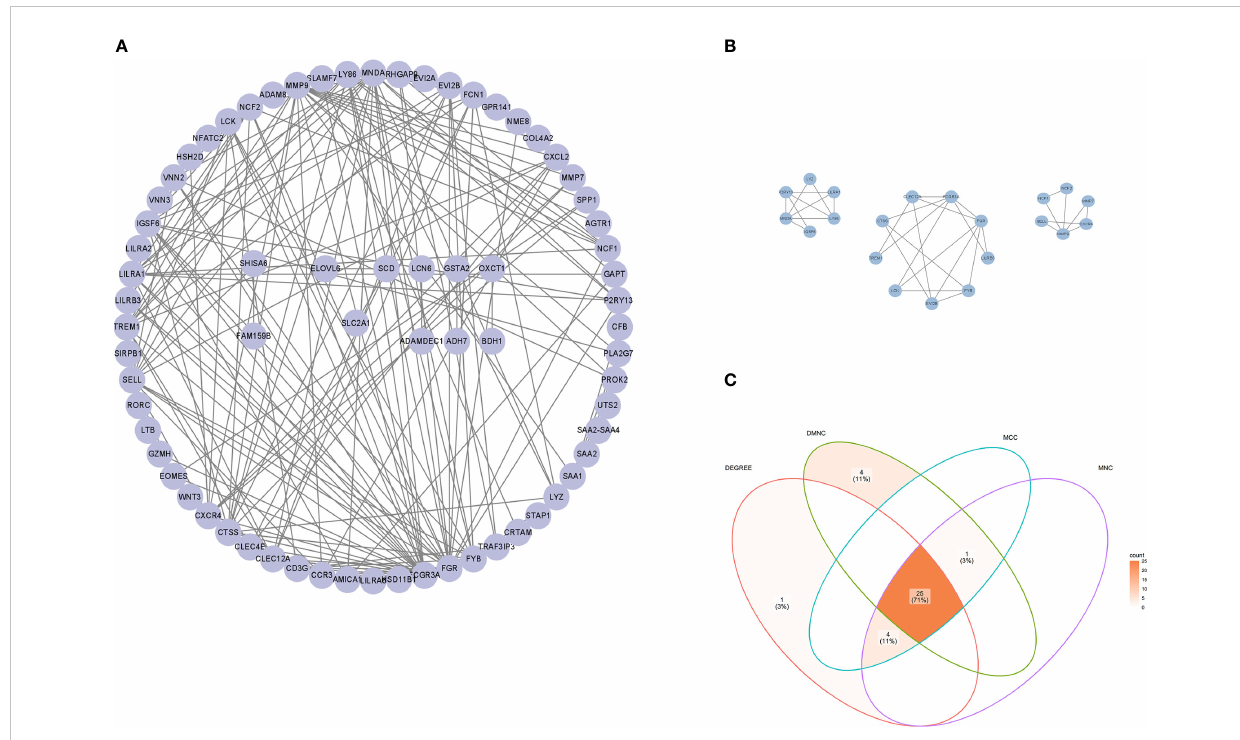
FIGURE 3 PPI network of hub genes. (A) PPI network of common DEGs constructed using the STRING database. (B) Three gene modules were identi fi ed by the MCODE plugin. (C) Venn diagram showing 25 common hub genes identi fi ed by MCC, MNC, Degree and DMNC algorithms using the CytoHubba plugin. PPI, protein-protein interaction; DEGs, differentially expressed genes; MCC, maximal clique centrality; DMNC, density of maximum neighborhood component; MNC, maximum neighborhood component.